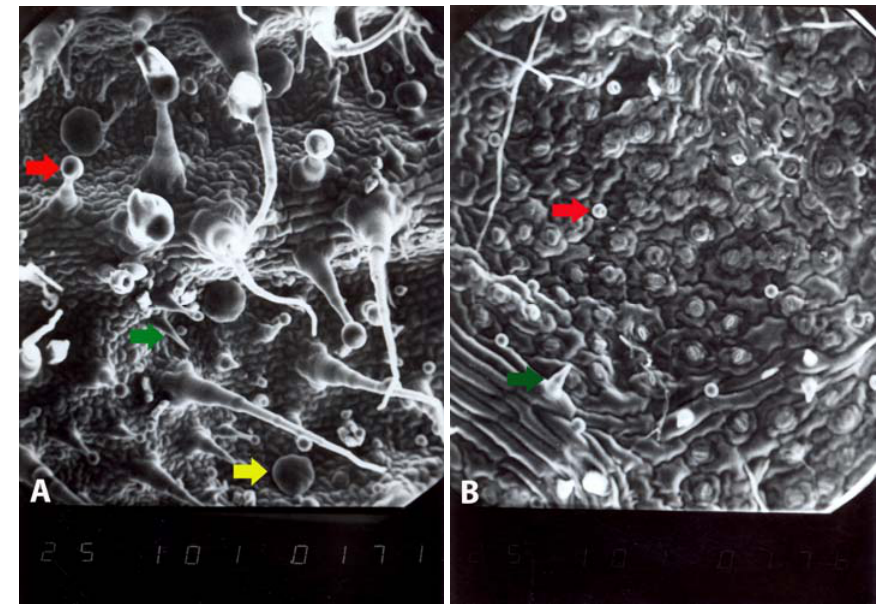
Figure 3. Glandular and non-glandular trichomes on abaxial epidermis of S. pratensis (A) and S. bertolonii (B) leaf. Non-glandular trichome (green), capitate glandular trichome with a short stalk (red), peltate glandular trichome